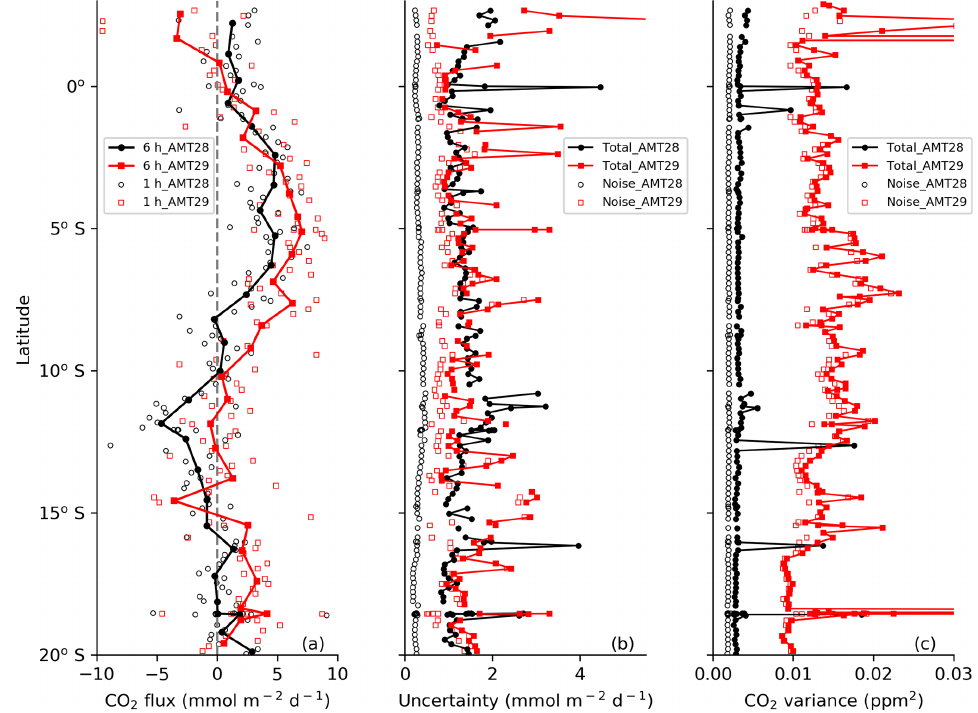
Figure 4. (a) Air–sea CO 2 fluxes (hourly and 6h averages), (b) random uncertainty in flux (total and due to instrument noise only), and (c) variance in CO 2 mixing ratio (total and due to instrument noise only) for two Atlantic cruises. Table 3. Variance in the CO 2 mixing ratio estimated using Eqs. (8) and (11) for the Arctic (JR18006/7, Picarro G2311-f) and Atlantic cruises (AMT28, Picarro G2311-f; AMT29, LI-7200). Total CO 2 variance ( σ 2 c ) consists of white noise ( σ 2 c latter can be further broken down to the CO 2 variance due to vertical flux ( σ 2 c